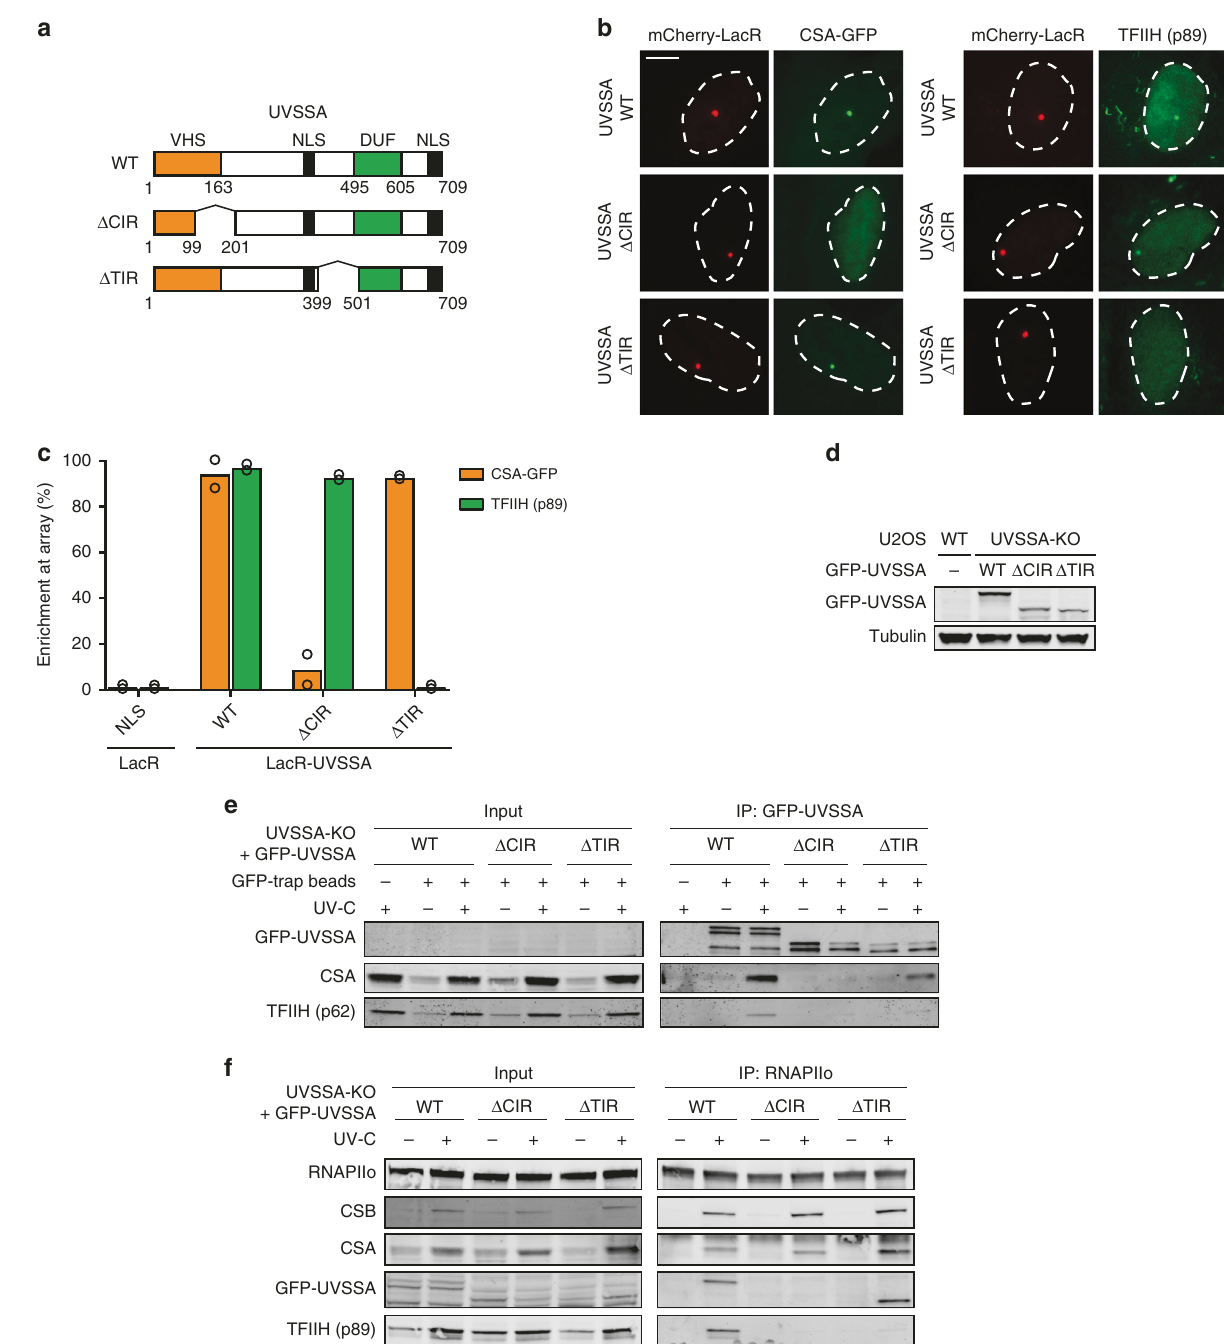
Fig. 6 UVSSA is the key protein that recruits TFIIH. a A schematic representation of UVSSA WT and deletion mutants. The CSA-interacting region (CIR) and TFIIH-interacting region (TIR) are indicated. b Recruitment of CSA-GFP and TFIIH (p89) to the LacO array upon tethering of the indicated mCherry-LacR fusion proteins (scale bar = 5 µ m). c Quanti fi cation of CSA-GFP and endogenous TFIIH (p89) co-localization at the LacO array. Each symbol represents the mean of an independent experiment ( n = 2, >50 cells collected per experiment). d Western blot analysis of U2OS (FRT) and UVSSA-KO cells complemented with GFP-UVSSA WT , GFP-UVSSA Δ CIR , and GFP-UVSSA Δ TIR ( n = 2). e Co-IP of GFP-UVSSA WT , GFP-UVSSA Δ CIR , and GFP-UVSSA Δ TIR . f Endogenous RNAPIIo Co-IP in GFP-UVSSA WT , GFP-UVSSA Δ CIR , and GFP-UVSSA Δ TIR cell lines. At least two independent replicates of each IP experiment were performed obtaining similar results. See also Supplementary Fig. 7b, c for additional Co-IP data. Source data are provided as a Source Data fi